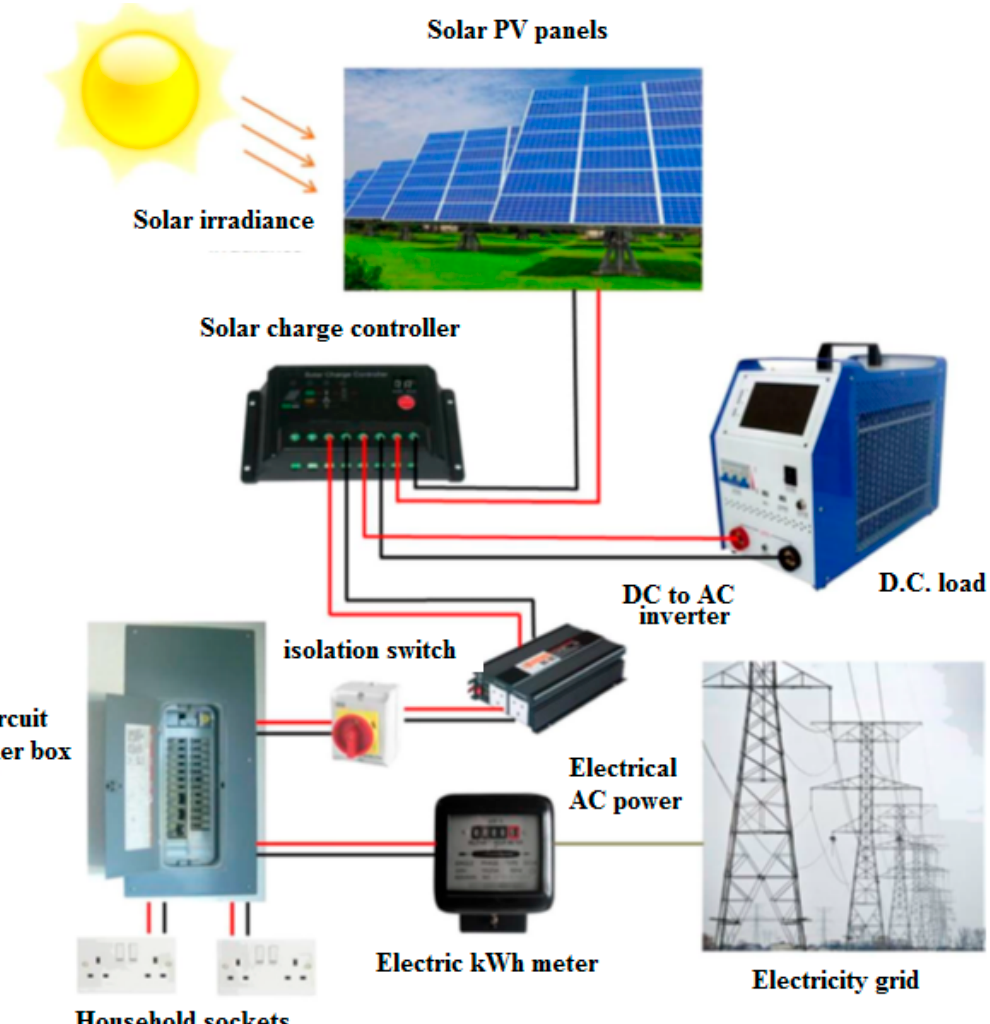
Figure 5. Components of the grid-connected photovoltaic (PV) system.